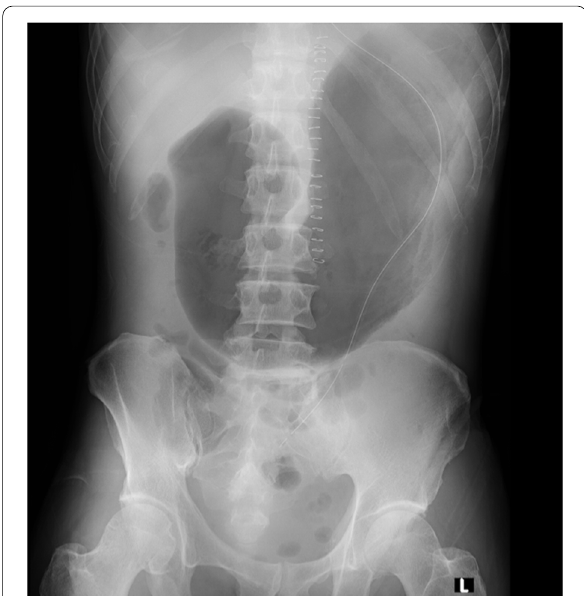
Fig. 2 Abdominal radiograph on POD 10 showing the patient’s distended stomach, which was likely owing to aerophagia and nasogastric tube malfunction. The tube was repositioned to drain the air. POD, postoperative